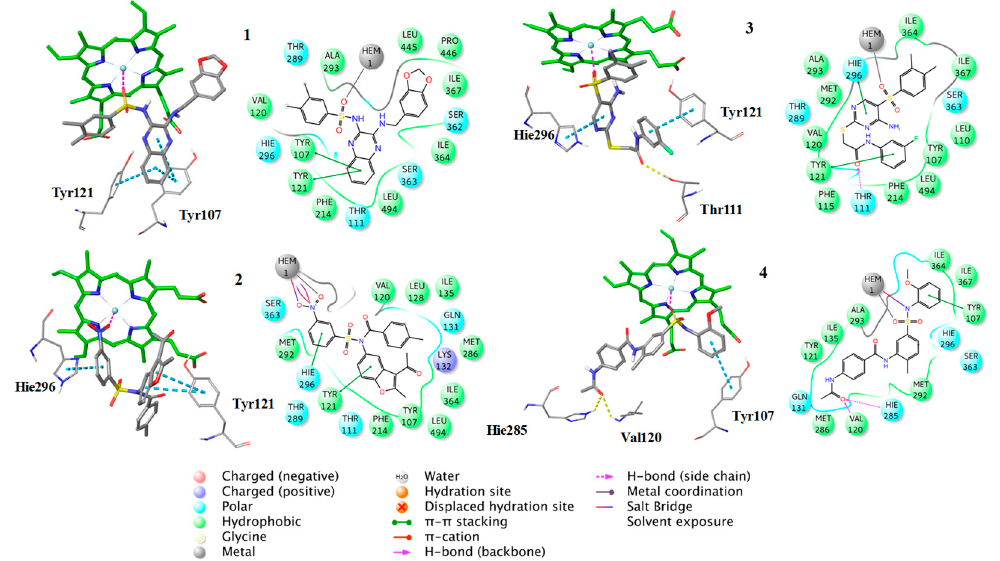
Figure 7. Binding poses of the compounds 1–4 , with the corresponding 2D ligand interaction diagrams, derived from molecular docking studies. Hie is the deprotonated His.